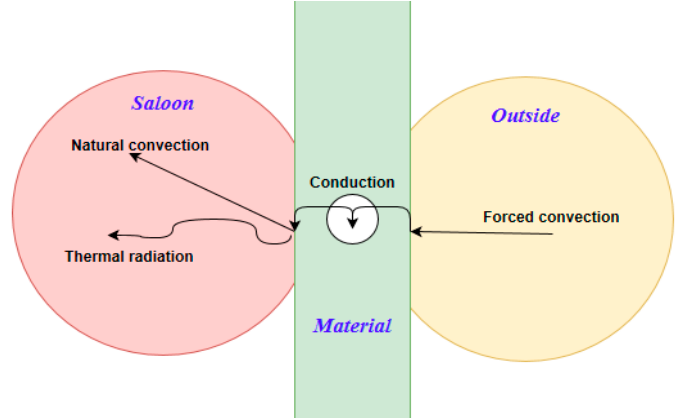
Figure 7. Types of heat transfer through materials.